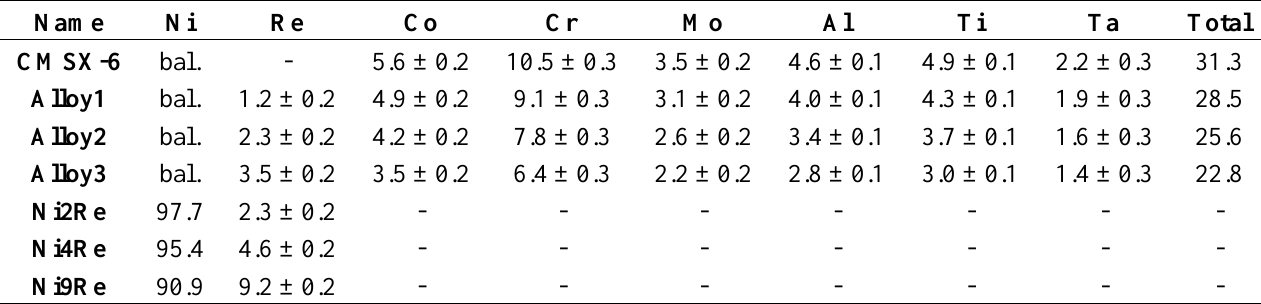
Table 1. Chemical composition of Ni-based alloys in